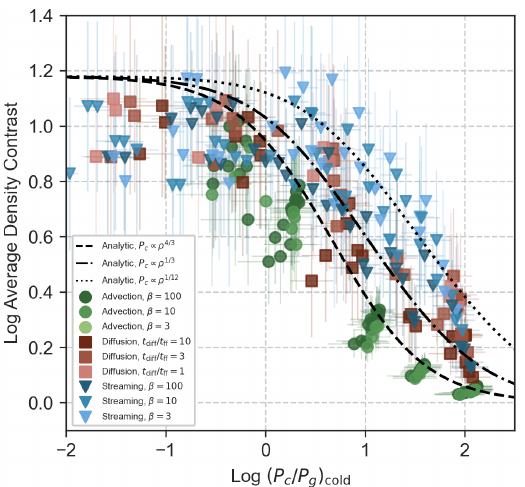
Figure 2. The average density contrast between cold and hot gas phases as a function of cosmic ray pressure support in the cold gas [199]. Each point represents a time-averaged measurement from an idealized simulation of thermal instability with varying initial conditions and cosmic ray physics. The black lines show different analytical predictions for various degrees of coupling between cosmic rays and gas. With increasing cosmic ray pressure, the density of cool gas decreases. However, the detailed quantitative predictions are sensitive to the invoked cosmic ray transport